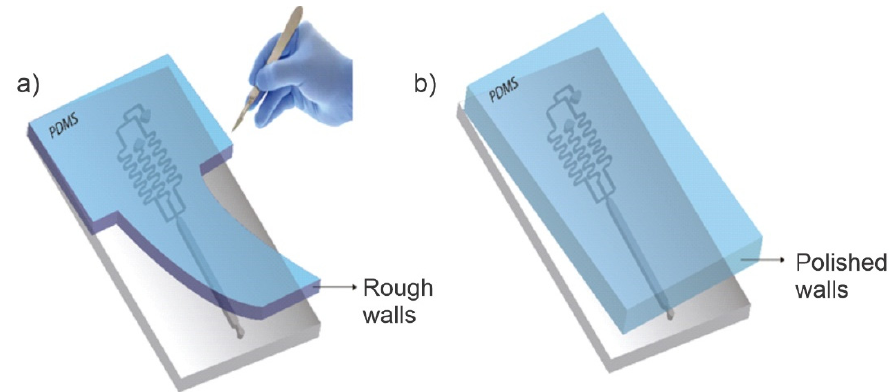
Figure 4. Stripping of the PDMS slab. ( a ) Traditional methodology, the user cuts it manually with the scalpel. ( b ) The reproducible and safe (REPSAF) methodology proposed in this work.